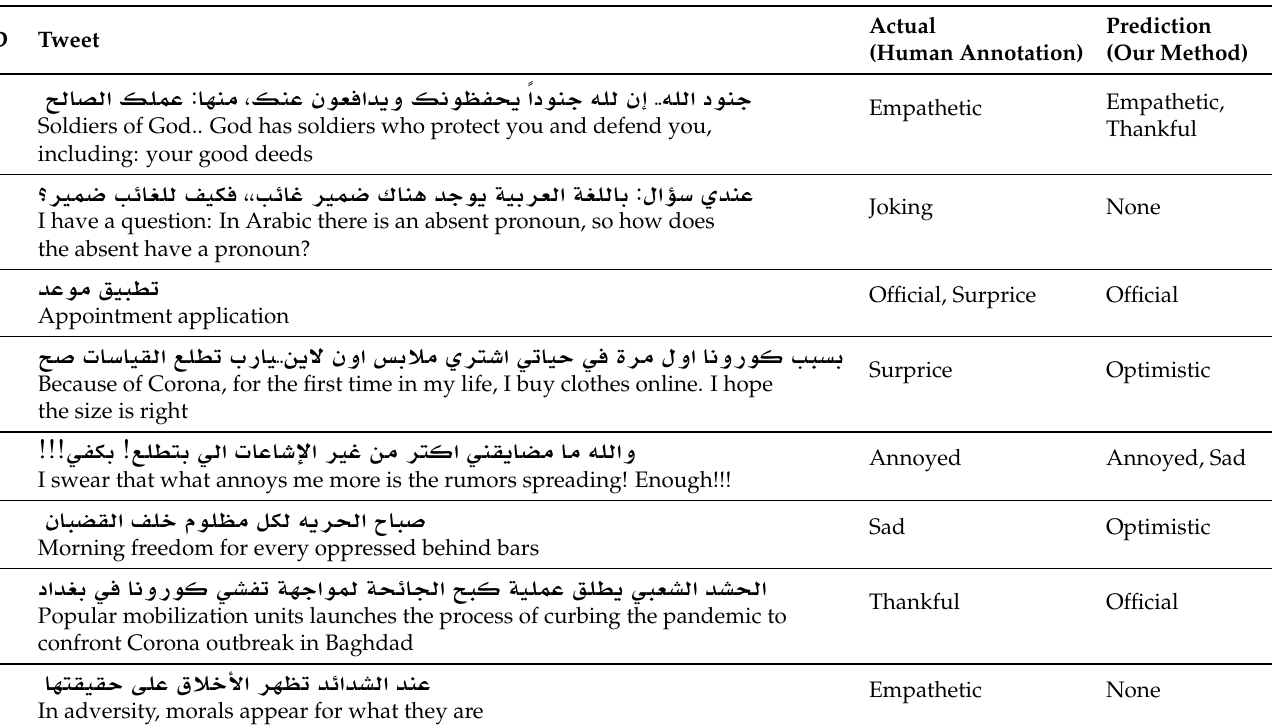
Table 4. Misclassified tweets from SenWave dataset.